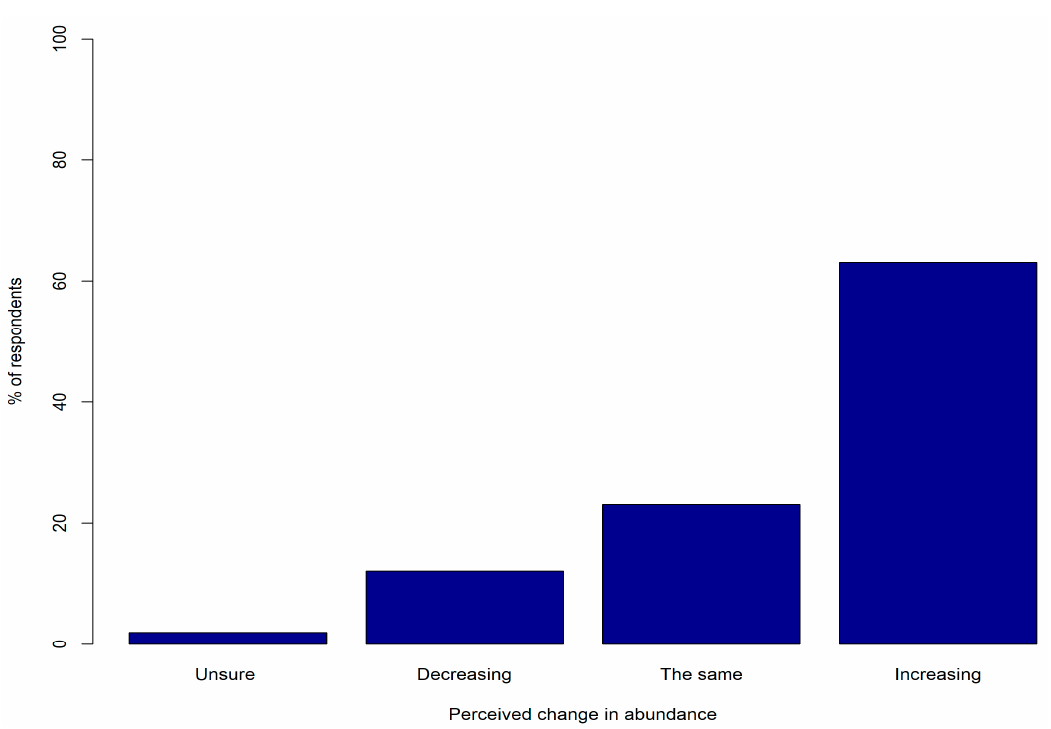
Figure 2. Perceived abundance of aquatic plants in Lake Léman.